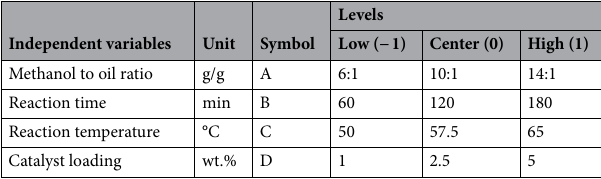
Table 1. The RSM design’s independent variables and their levels.